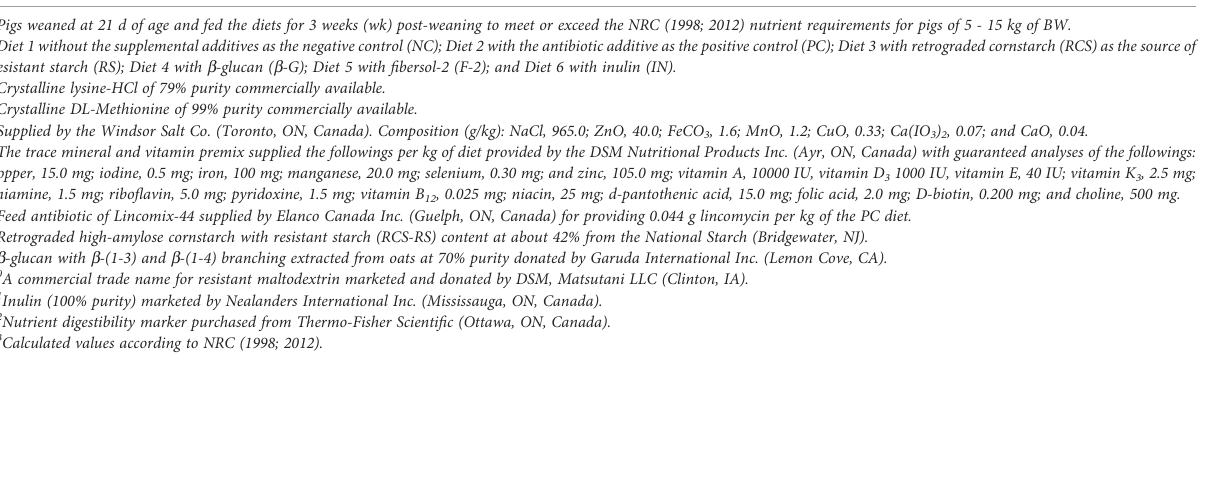
TABLE 1 Composition of experimental diets for the weanling pigs of 5 - 15 kg of body weight (BW) 1 . Diet